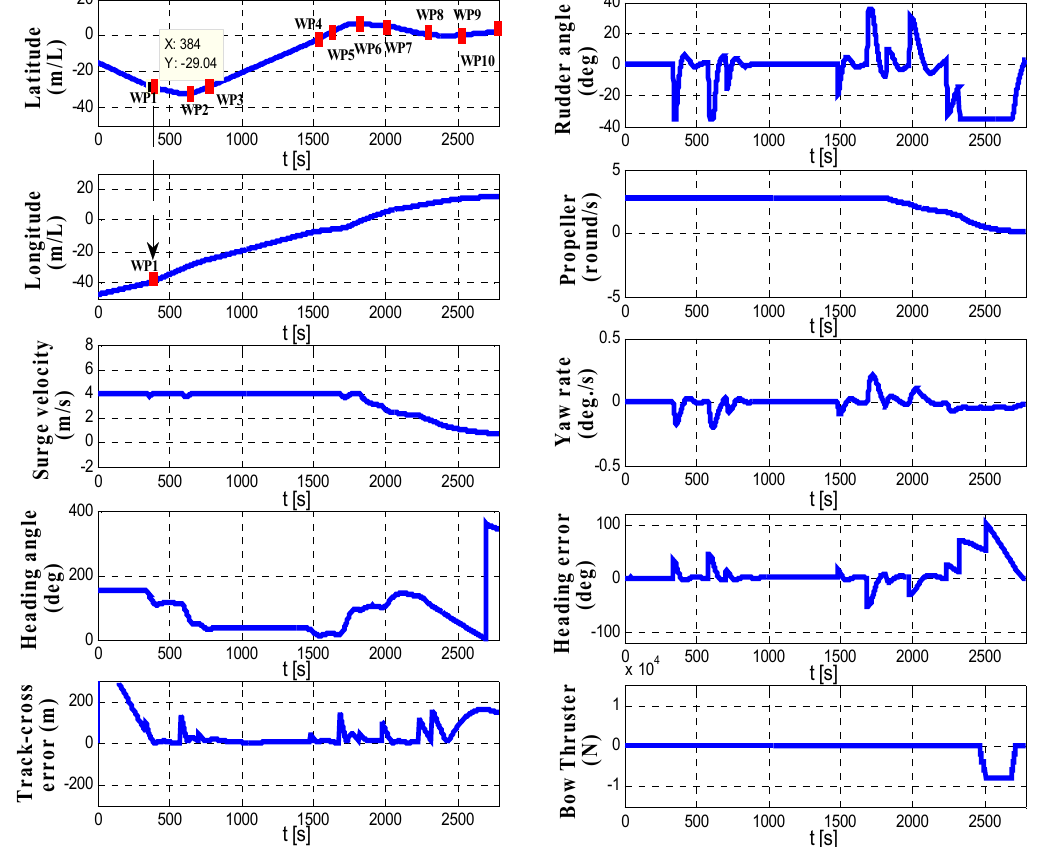
Figure 11. The time history of ship motion controlled by the automatic ship navigation system.